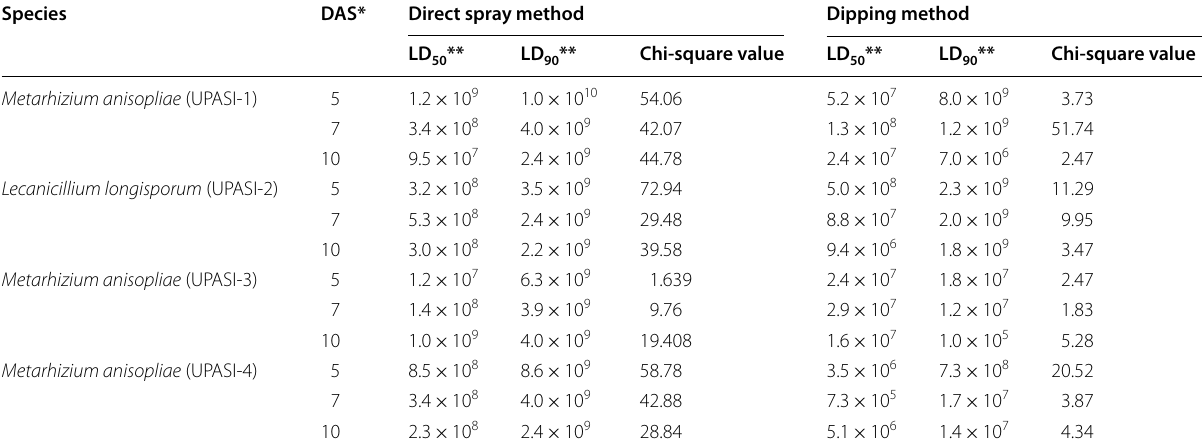
* DAS Days after spray; **Spores/mL; LD 50 =